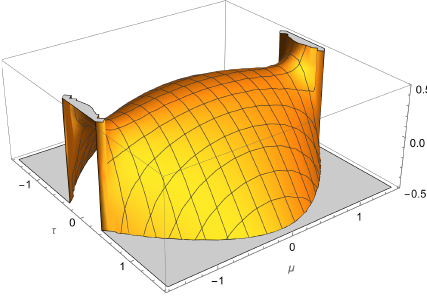
Figure 4 . 3D plot of dilaton field for Janus deformation with γ 2 = 6 / 5